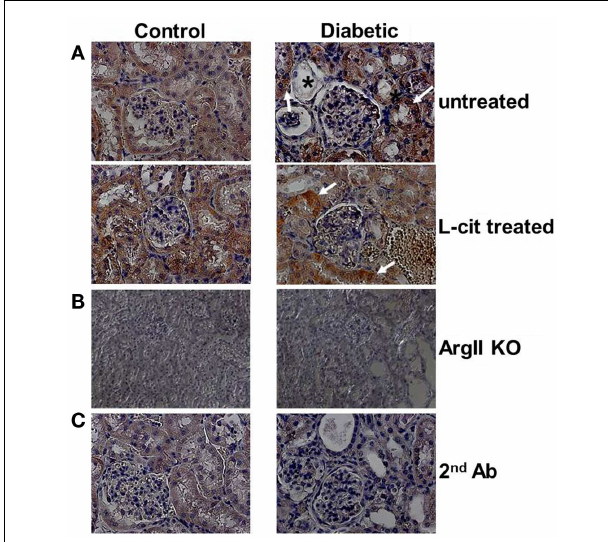
FIGURE 4 | Periodic acid Schiff-stained paraffin-embedded kidney sections . (A) Representative photomicrographs of PAS-stained kidney sections from: untreated (ContWT) and L -cit-treated (Lcit-ContWT) control wild type, and control ArgII knock out (Ctrl-ArgII KO) mice (upper). Untreated (DiabWT) and L -cit-treated (Lcit-DiabWT) diabetic wild type, and diabetic ArgII knock out (Diab-ArgII KO) mice (lower) at 16weeks (20 × ). Morphological alterations of a selected area (rectangle) observed in Diab WT and Diab-ArgII KO kidneys are shown at higher magnification (40 × immersion oil) in: (B) a hypertrophied glomerulus with thickening of Bowman’s capsule is observed (arrow heads). Surrounding tubules show markedly thickened and wrinkled tubular basement membranes, and partial disruption of brush border (arrows). Interstitial expansion and hypercellularity around the glomerulus and surrounding tubules are also observed.These effects were markedly attenuated by L -cit treatment